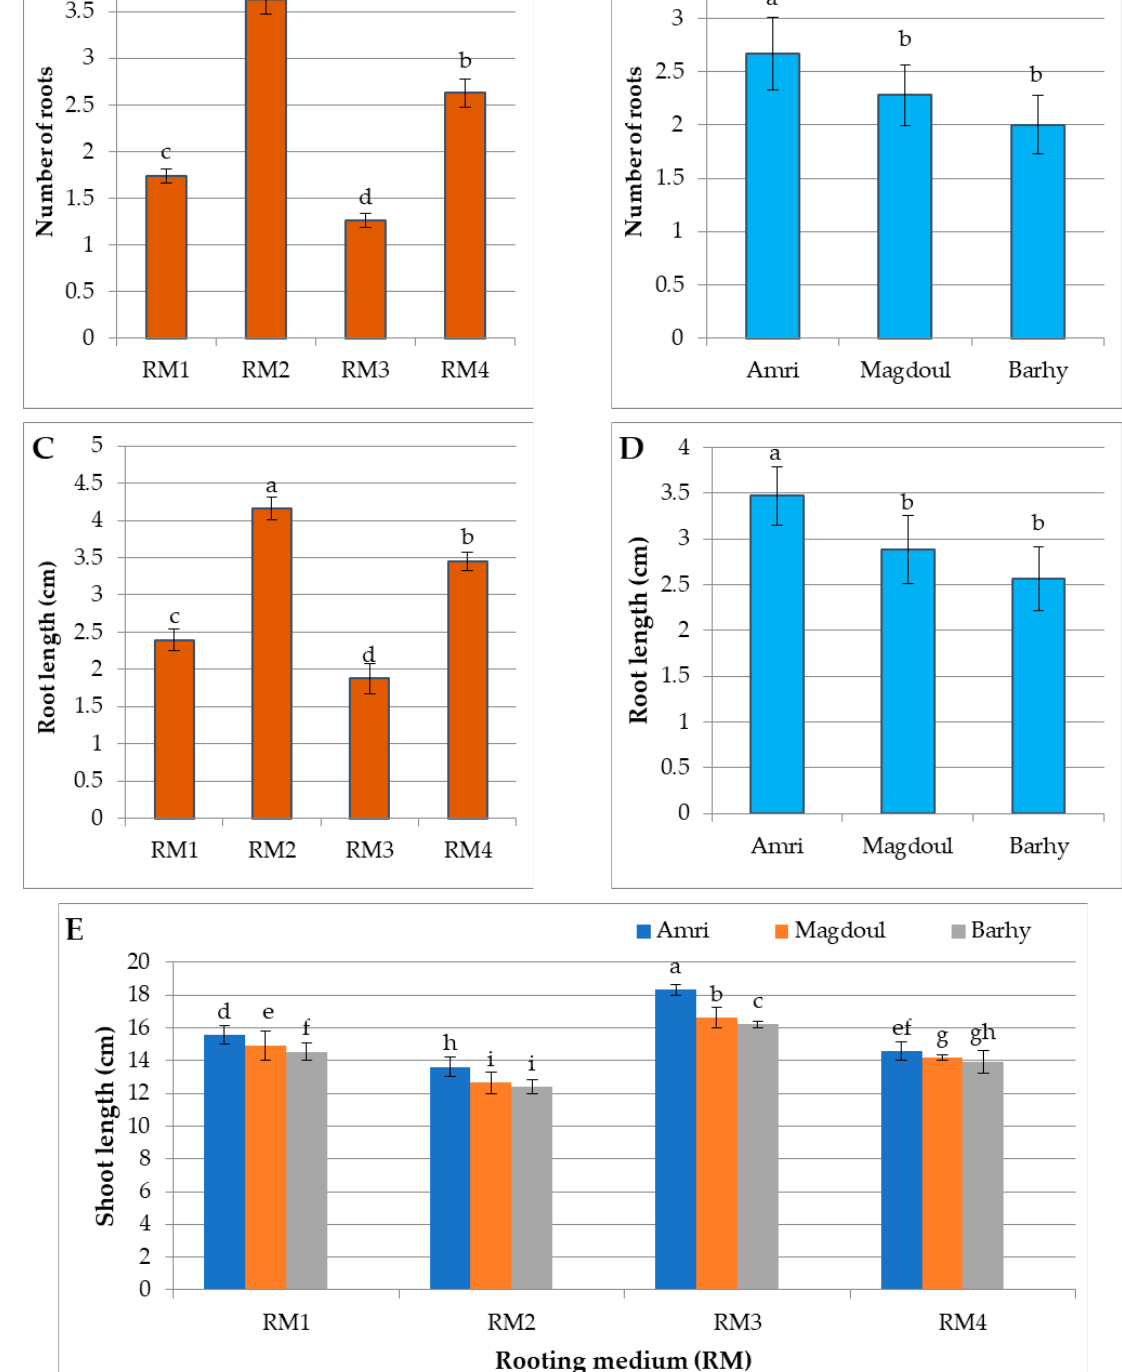
Figure 7. ( A ). Roots numbers of the four rooting media (RM1, RM2, RM3 and RM4). ( B ). Roots numbers of the three varieties (Amri, Magdoul and Barhy). ( C ). The root length of the four rooting media (RM1, RM2, RM3 and RM4). ( D ). The root length of the three varieties (Amri, Magdoul and Barhy). ( E ). The shoot length of the three varieties (Amri, Magdoul and Barhy) on the four rooting media (RM1, RM2, RM3 and RM4). Note: Charts with the same letter are not statistically different at p < 0.05. Different letters denote a significant difference among culture media at p < 0.05. Table 3. Mean sum of squares (MS) of roots number, root length and shoot length in Amri, Barhy and Magdoul varieties .